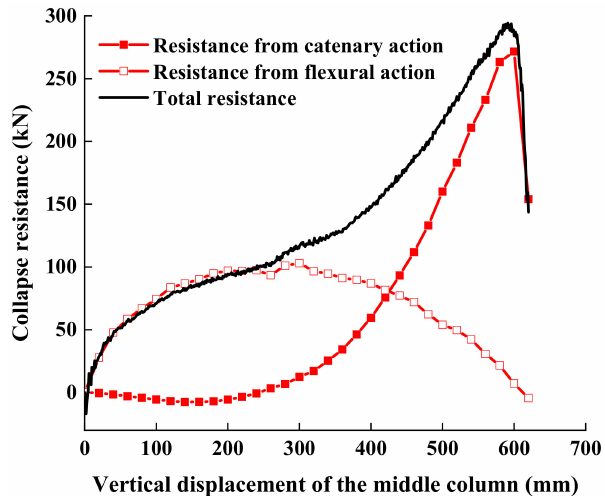
Figure 12. Collapse resistance of the composite